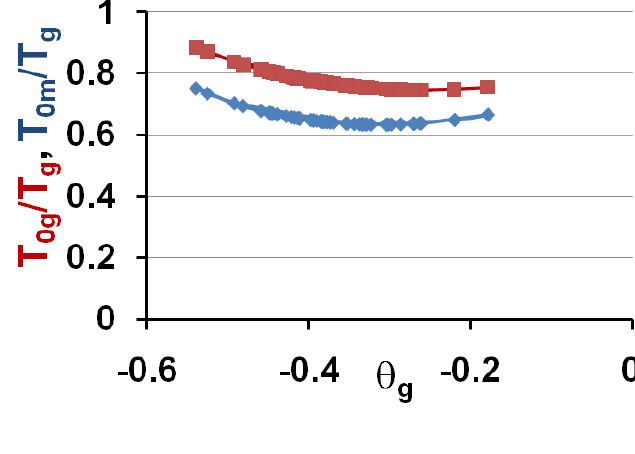
/T and T /T of the free-volume disappearance temperatures to og g 0m g are plotted versus  g